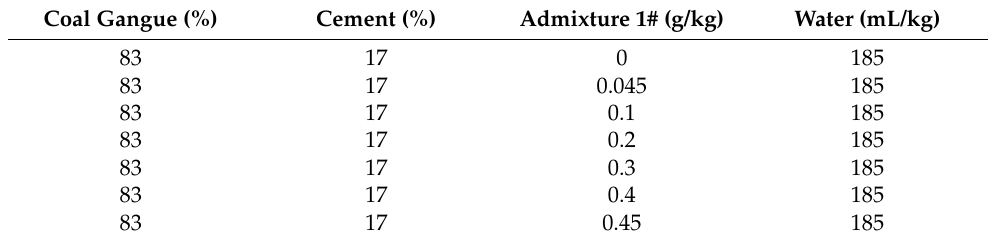
Table 5. Data of base ratio of the spiking amount of admixture. Coal Gangue (%)